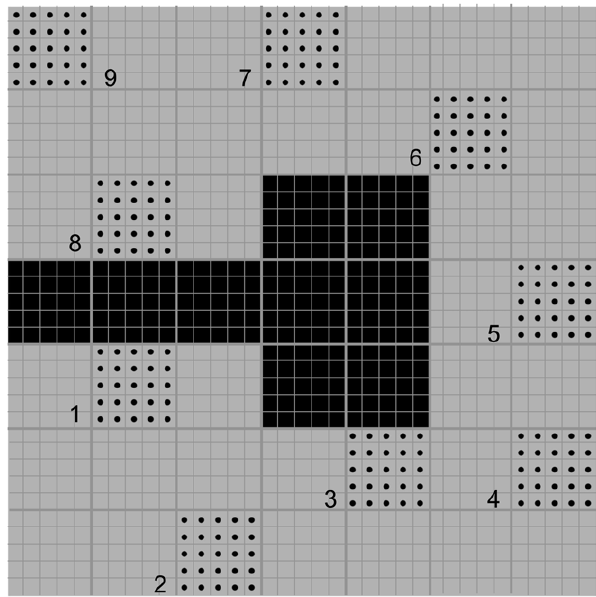
Figure 2. The cost surface used in the simulation of isolation by resistance. Grey cells represent low cost and black cells represent a barrier. We simulated gene flow between black dots for 250 generations. Numbers represent sites. Juveniles can disperse up to two sites away from their natal site. Unsampled populations are sites 4, 5, and 6; they contribute to gene flow but are not included in the calculation of genetic differentiation.